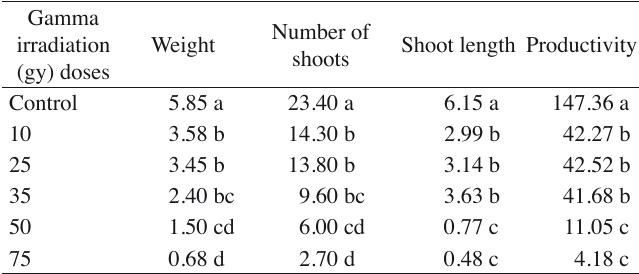
Table 1 - Effect of gamma irradiation six weeks after the treatment on in vitro apricot shoot